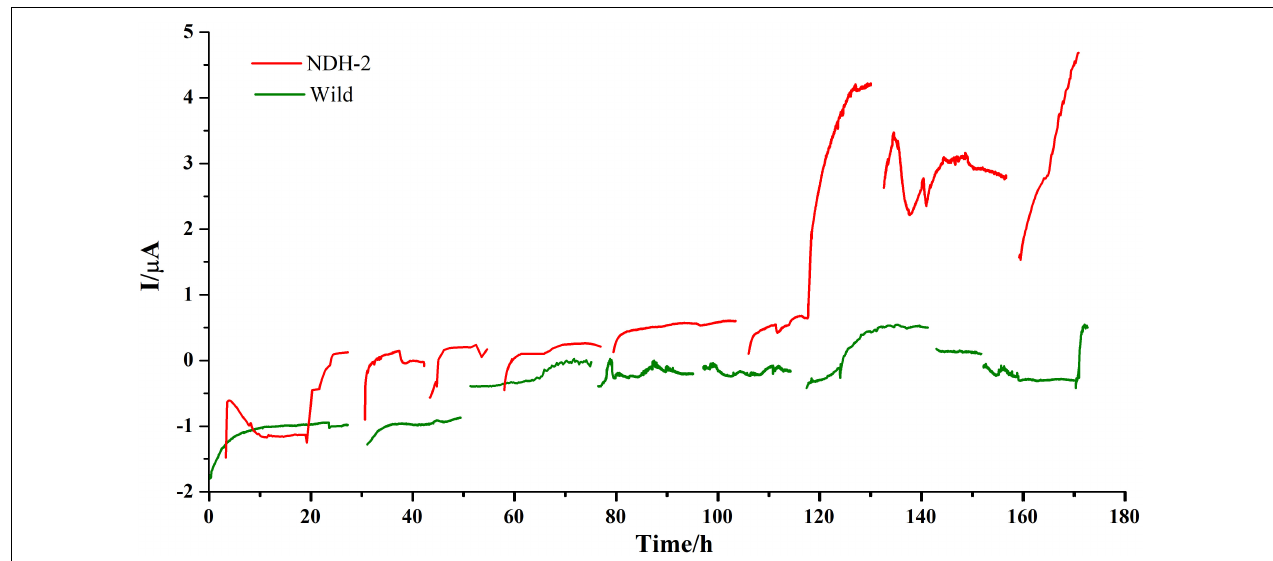
FIGURE 5 | Bioelectrogenic activity of NDH-2 and wild BES reactors poised at – 0.160 V. NDH-2 induced culture has shown ninefold increase in current production compared to uninduced BES